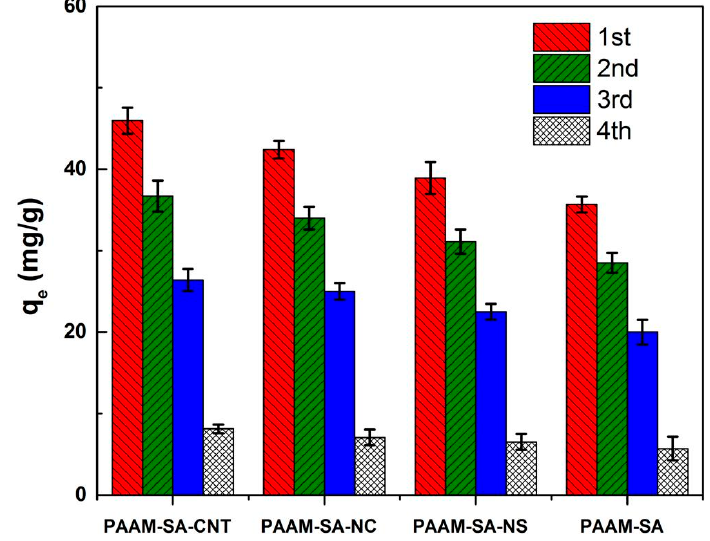
Figure 8. Four adsorption–desorption cycles of Cu 2+ on the prepared hydrogels.